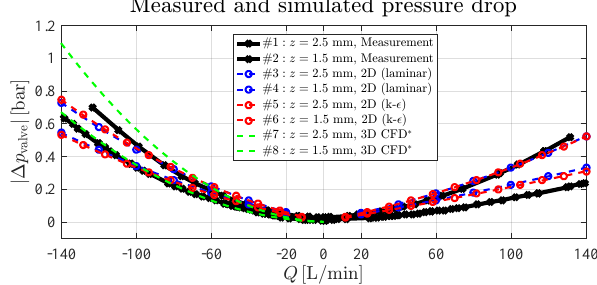
Figure 14: Simulated and measured valve pressure drops as a function of flow rate for differ- ent plunger